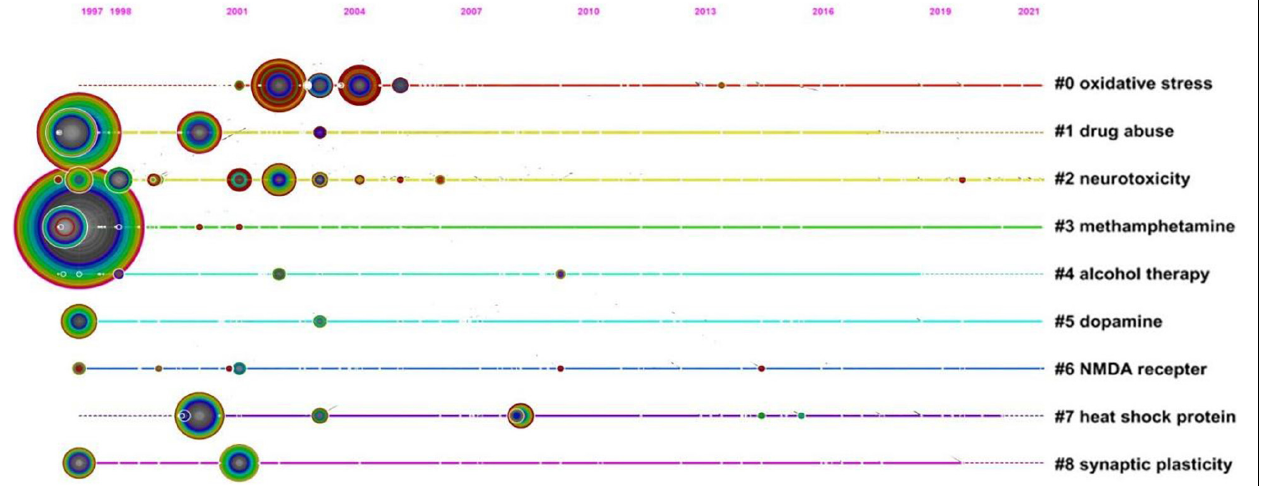
protein α -synuclein (Fornai et al., 2005; Wu et al., 2021).